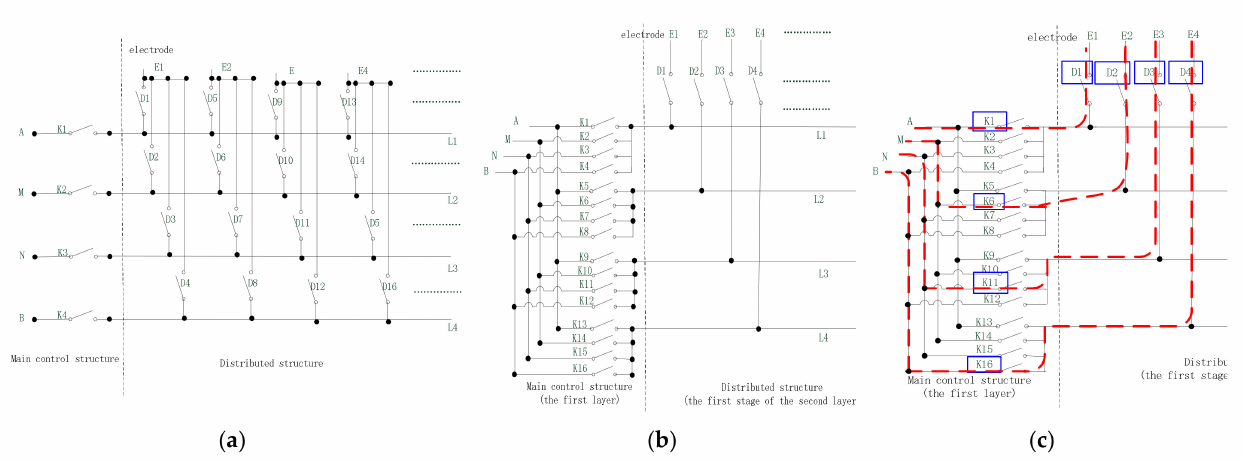
Figure 5. Topology of the distributed structure: TESD design ( a ) [24]; the first layer and the first stage of design of the second layer in HESD ( b ); Switch control map for E1-A, E2-M, E3-N, and E4-B ( c